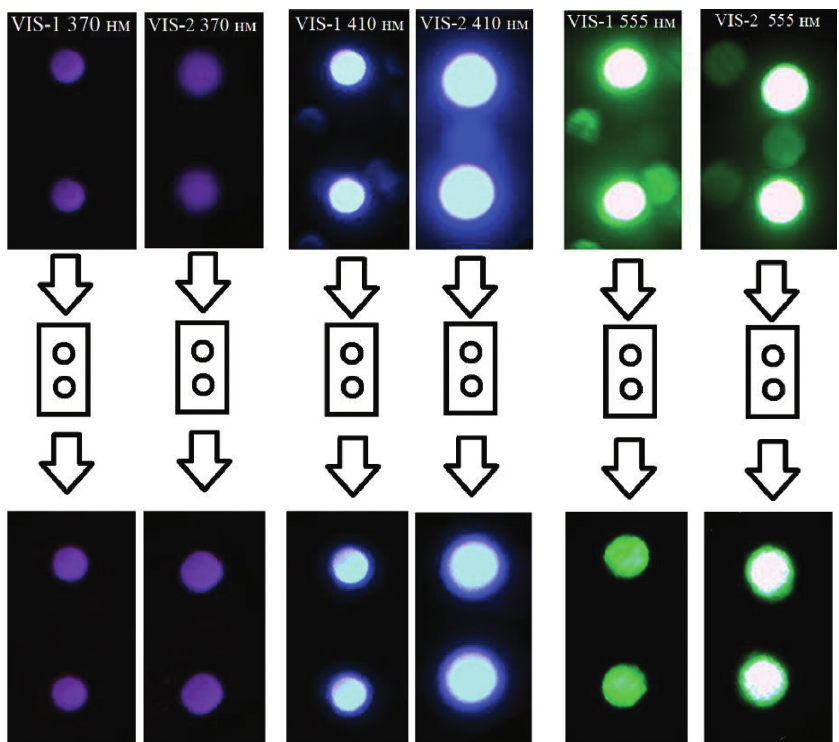
Figure 16: Image of field diaphragm in the focal planes of camera lenses for VIS-1 and VIS-2 units before and after input of blocking